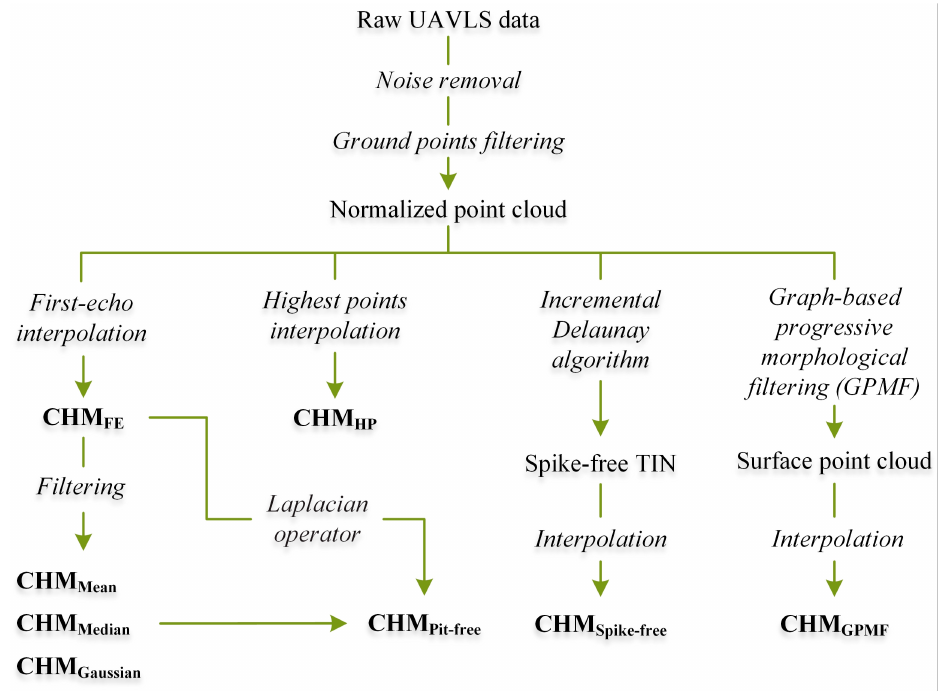
Figure 3. An overview of the workflow of CHMs generated by eight